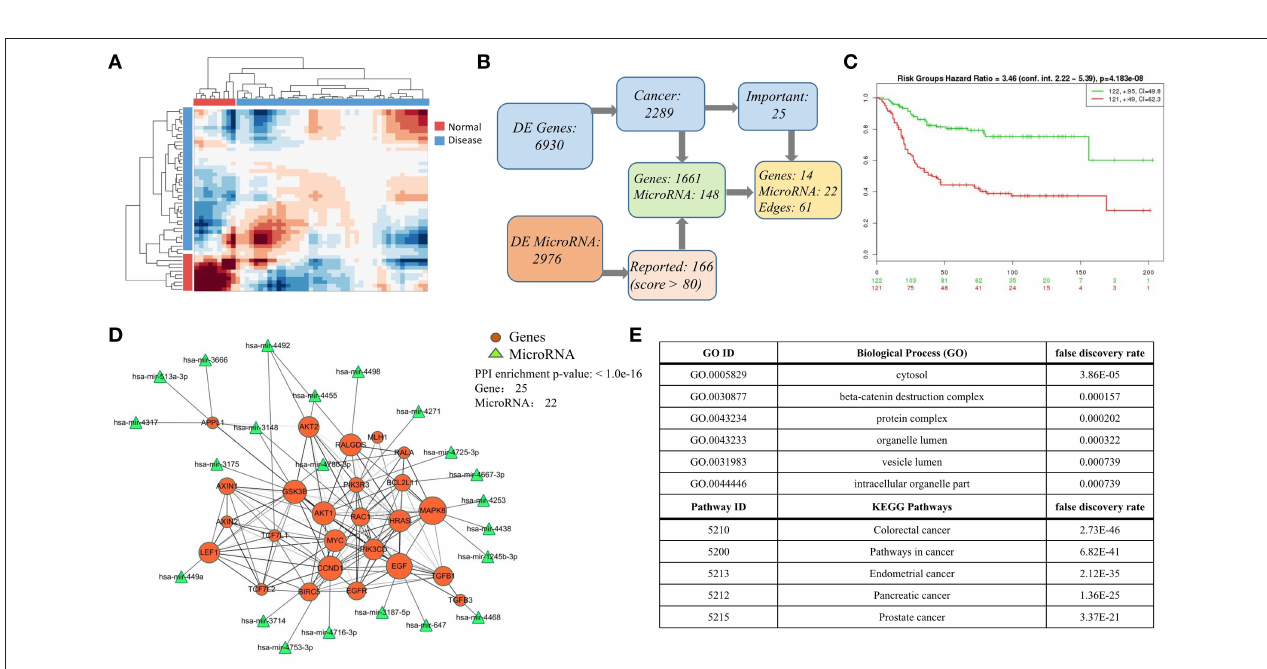
FIGURE 4 | The enhanced framework flow for integrating bulk datasets and comparison of PFA (A) The flow chart of HCI to integrating multiple heterogeneous omics data (B) A brief introduction to the datasets we used in this comparison. (C–E) Bars correspond to the average of the RDC values by running 100 times in each dataset. Red and gray colors correspond to result of HCI and PFA respectively.